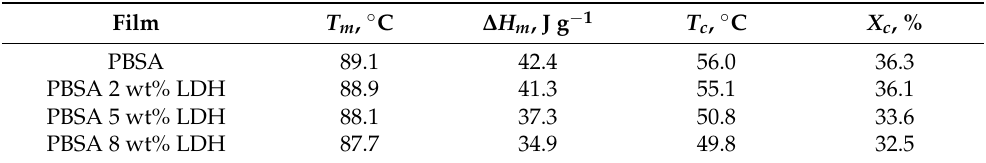
Table 1. DSC results of PBSA and PBSA nanocomposites summarizing the melting temperature ( T m ), enthalpy of fusion ( ∆ H m ), crystallization temperature ( T c ), and degree of crystallization ( X c , ) analyses were conducted with a heating rate of 10 ◦ C min − 1 . Film T m , ◦ C